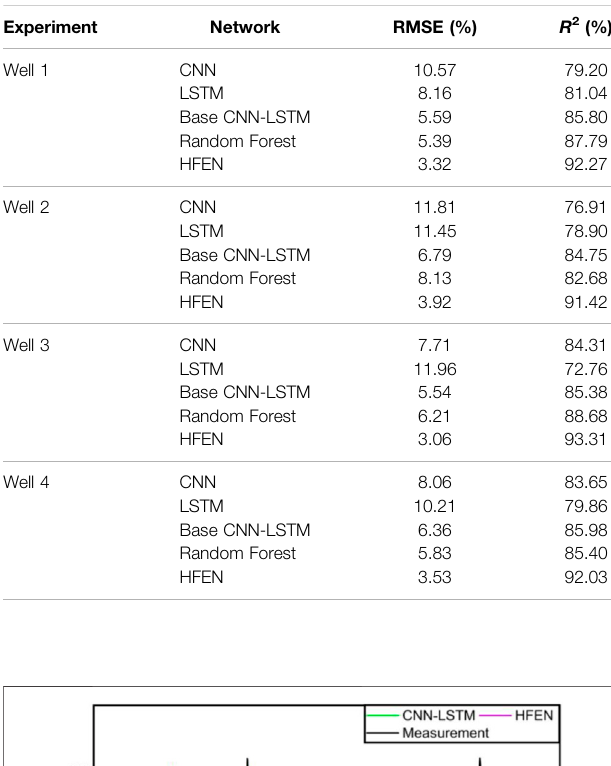
TABLE 3 | Comparison of HFEN-predicted results with other methods.